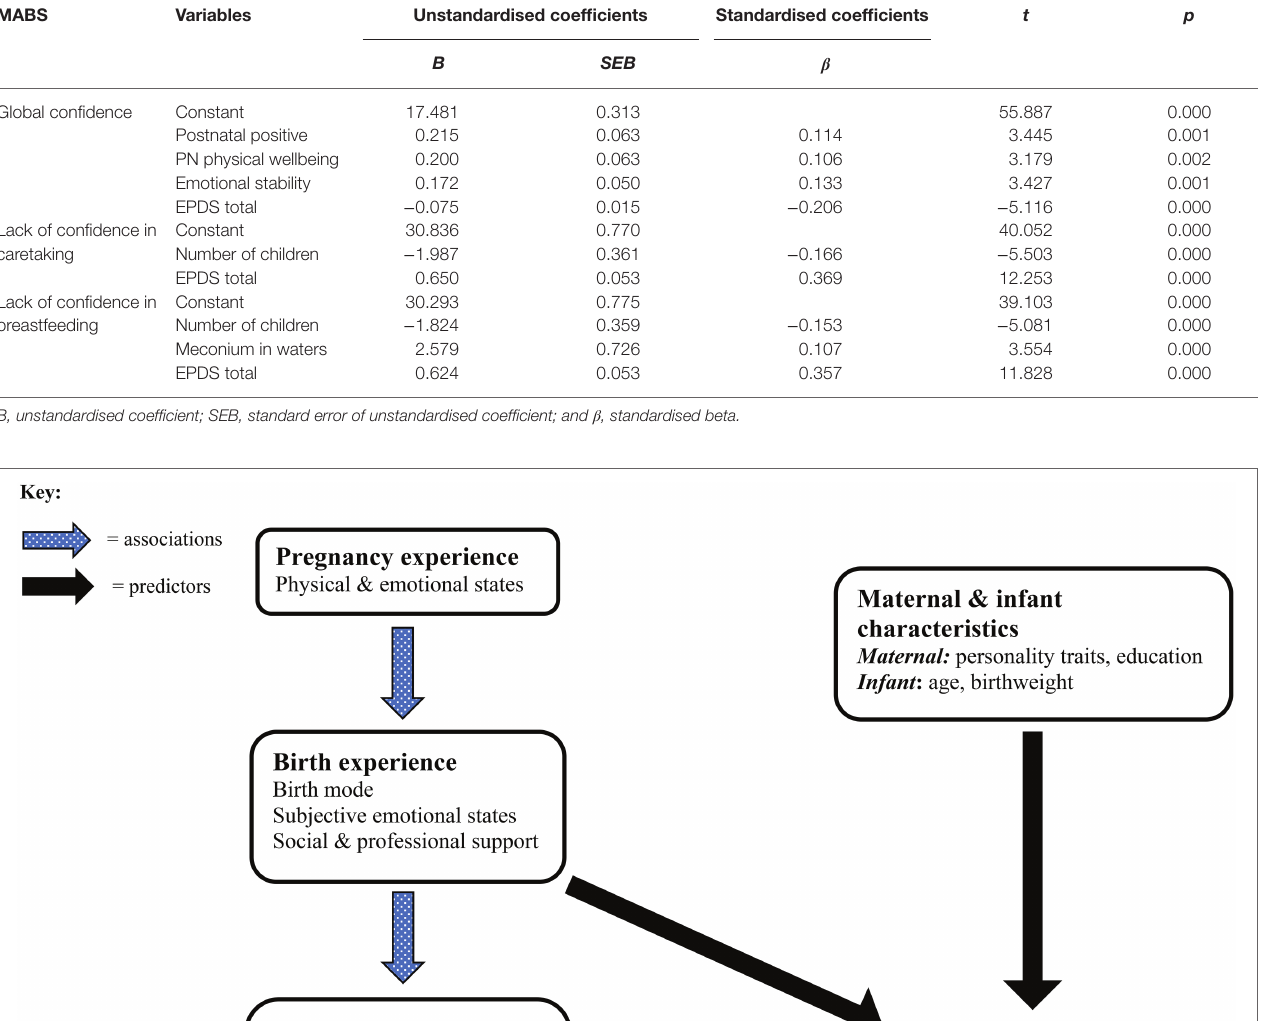
TABLE 11 | Predictors of maternal confidence and self-efficacy (MABS).